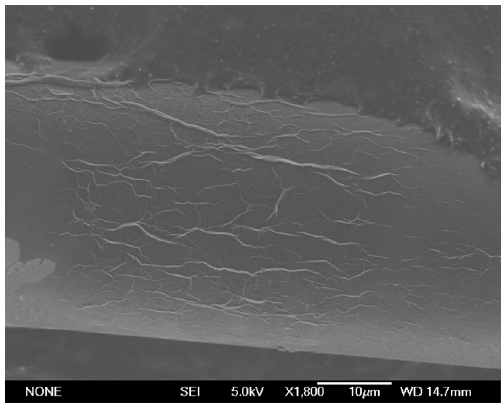
Figure 5. SEM image of the GO deposit on a tapered fiber, for an immersion time of 10 min and similar magnification ( × 1800) of that of Figure 4. In this case, we did not have any previous deposit on the taper, so the structure associated to GO is more evident.